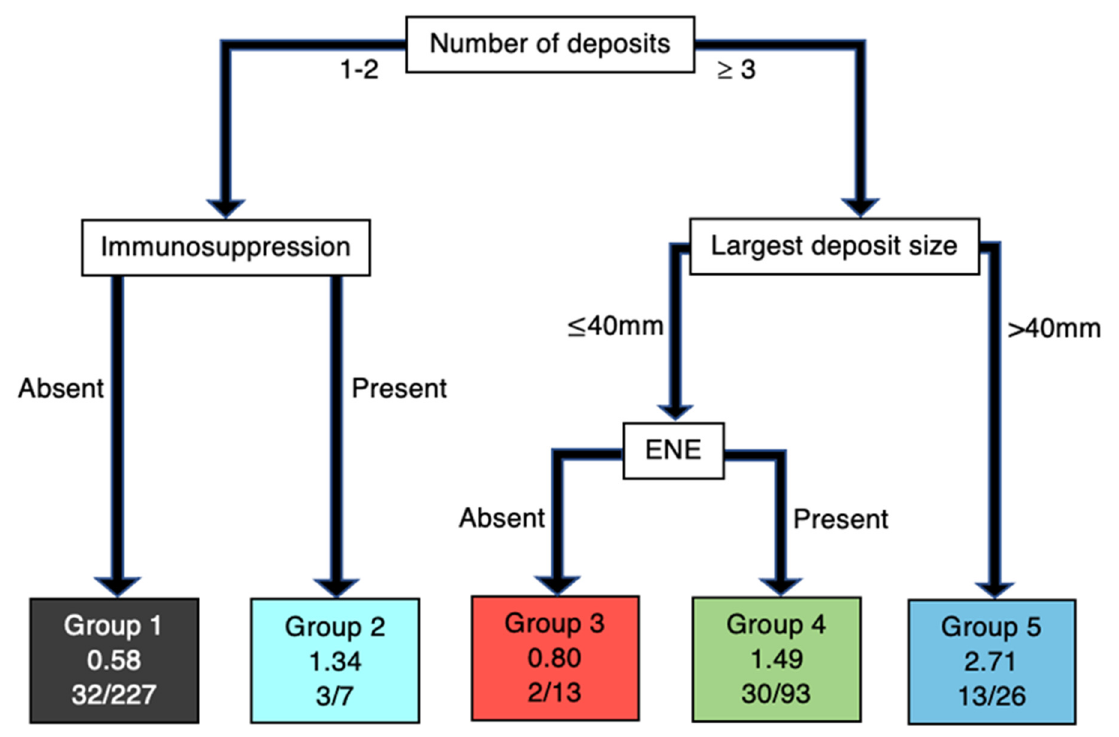
Figure 1. DSS Analysis. RPA decision tree. Groups 1 – 5 represented in leaves with Cox hazard ratio and DSS ratio (number of events observed in group/overall group number).